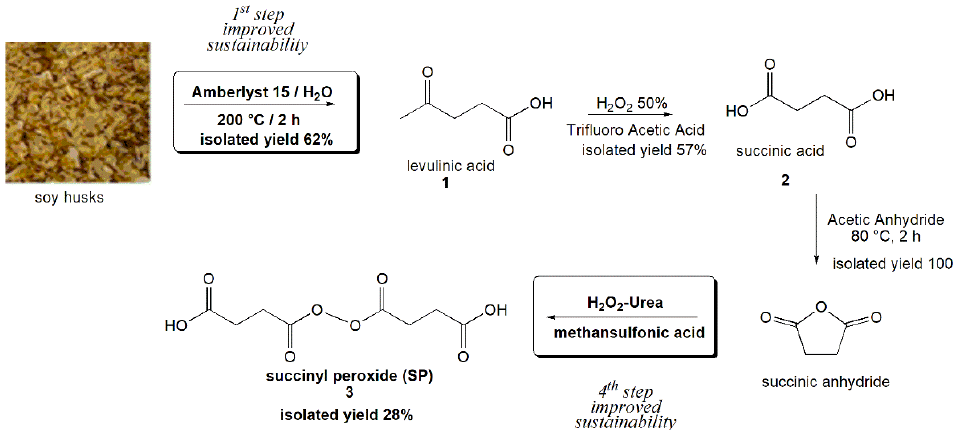
Figure 1. The improved synthetic strategy for producing biobased succinyl peroxide.